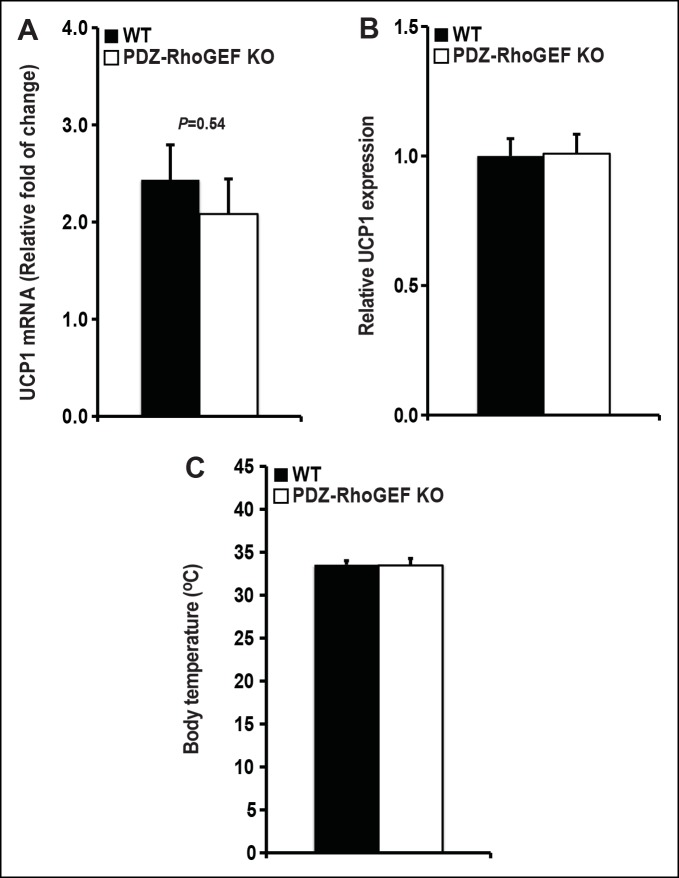
UCP 1 expression in BAT and core body temperature.(A) UCP1 expression in brown fat was determined by qPCR normalized to internal control GAPDH (n = 4). (B) UCP1 expression in IWAT was determined by qPCR normalized to internal control GAPDH (n = 4–5). (C)The core body temperature determined by rectal thermometer (n = 5–6). Statistical significance was calculated by a Student’s t test using Excel software (*p<0.05, **p<0.01, ***p<0.001).